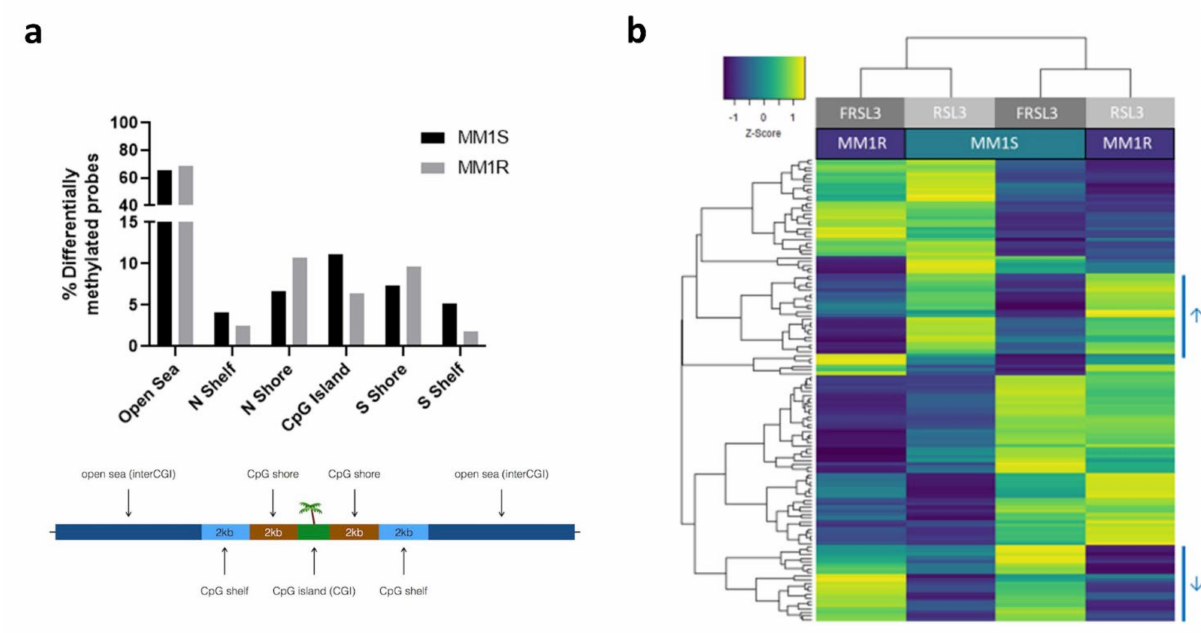
Figure 6. Local DNA methylation changes in MM1 cells after RSL3 treatment (with or without pre-treatment with ferrostatin-1 (FRSL3)). ( a ) Bar chart visualization of the percentage of significantly differentially methylated (FDR < 0.05, ∆ β difference > 0.10) CpG loci (y-axis) between RSL3 and ferrostatin-1 pre-treated RSL3 MM1 cells and their corresponding genomic compartments (x-axis). ( b ) Heatmap representation of the methylation level ( β -values) of the top common DMP CpG sites of MM1 cells treated with RSL3 (with or without pre-treatment with ferrostatin-1). β -values are represented as Z-scores, where the lowest methylation value is indicated in blue and the highest in